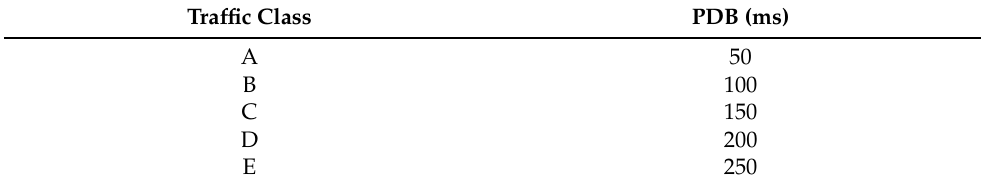
Table 2. Traffic Model for Multi-service Traffic